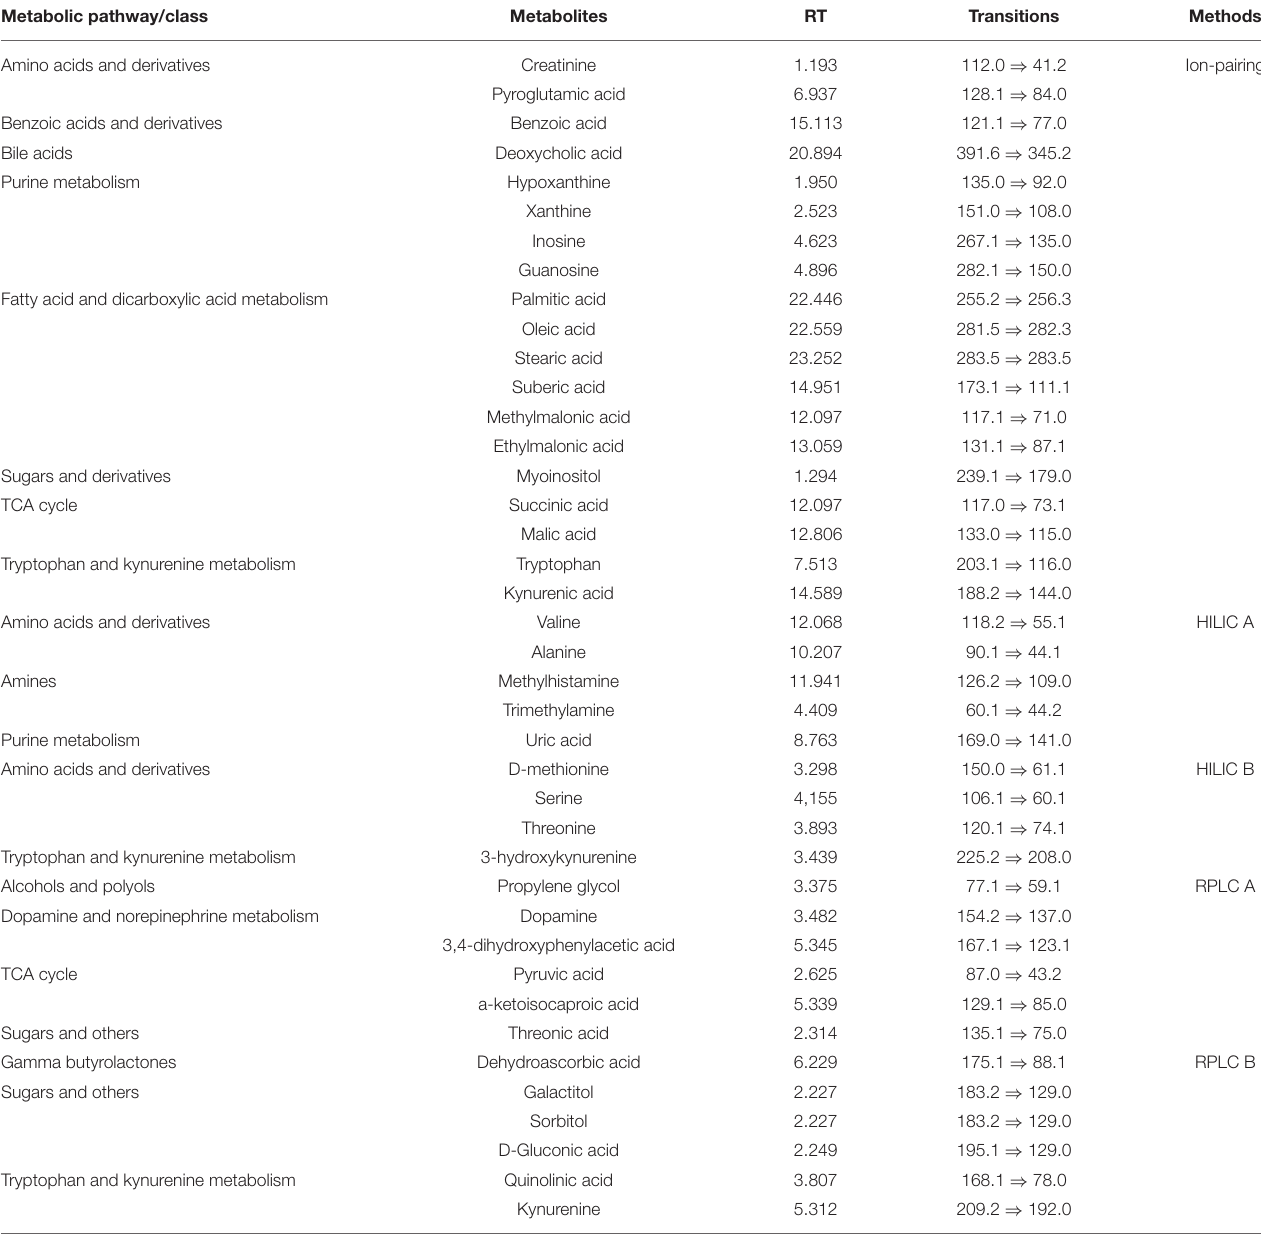
TABLE 2 | List of studied metabolites and their retention times and transitions in the assigned chromatographic method. Metabolic